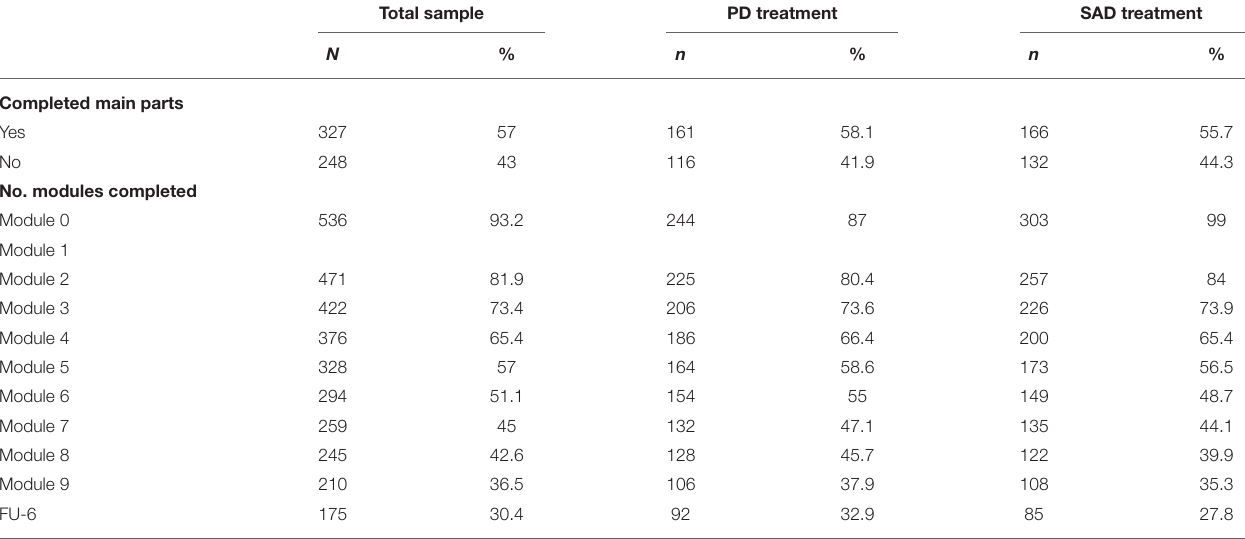
TABLE 4 | Descriptive data of dropout. Total sample PD treatment SAD treatment